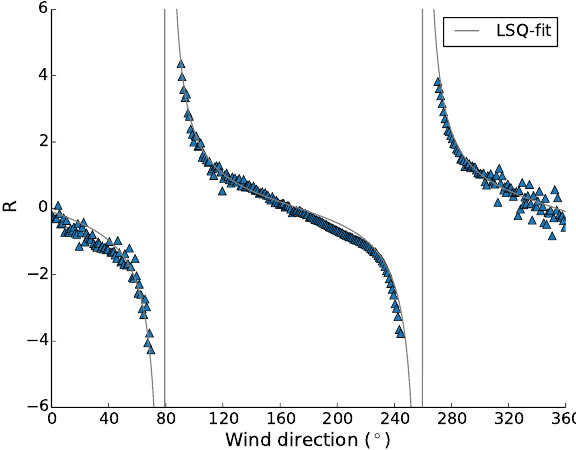
Figure 13. Calibration function R during sols 1–45.